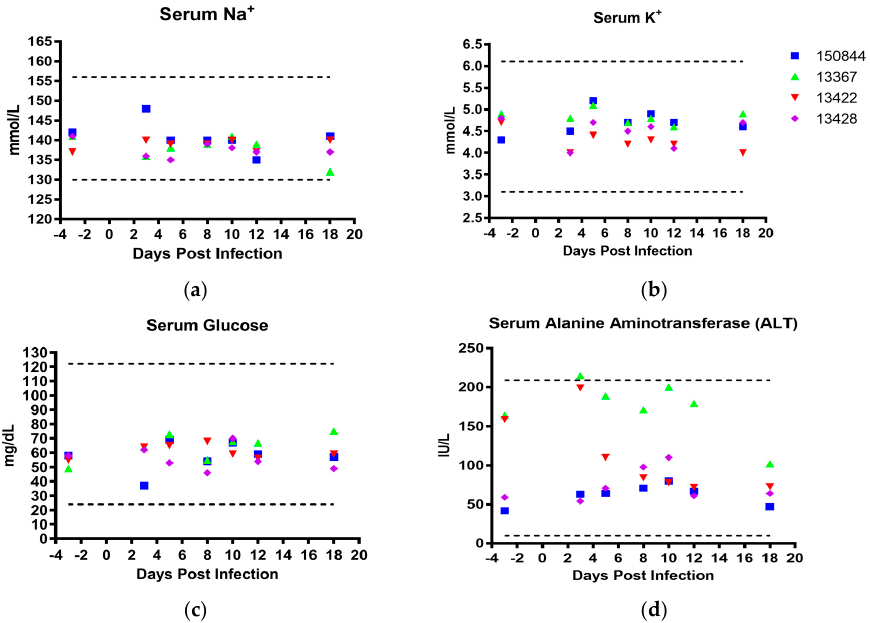
Figure 4. Serum Biochemistries. Sera was analyzed utilizing the VetScan VS2 system. ( a ) serum Na + in mmol/L, ( b ) serum K + in mmol/L, ( c ) serum glucose in mg/dL, and ( d ) serum alanine aminotransferase in IU/L. Macaque 150844 seen in blue, 13367 in green, 13422 in red and 13428 in purple. Dotted lines represent upper and lower reference ranges for analytes.